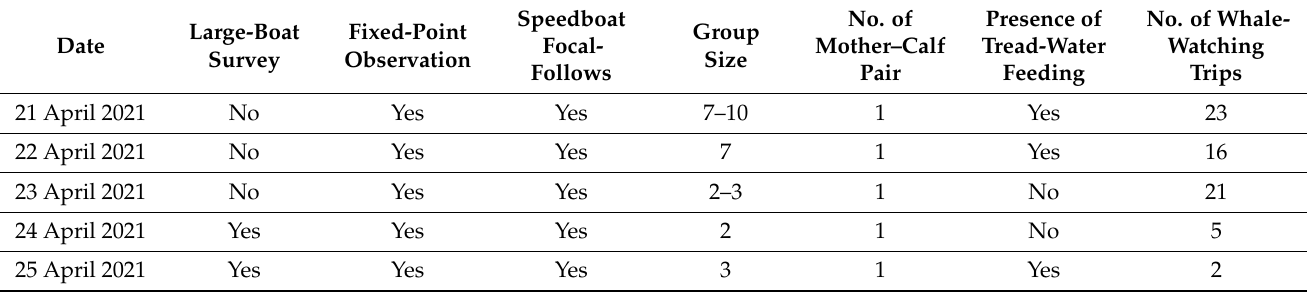
Table 1. Summary of survey information on Bryde’s whales around Weizhou Island, Beibu Gulf, China, from 21 April to 25 April